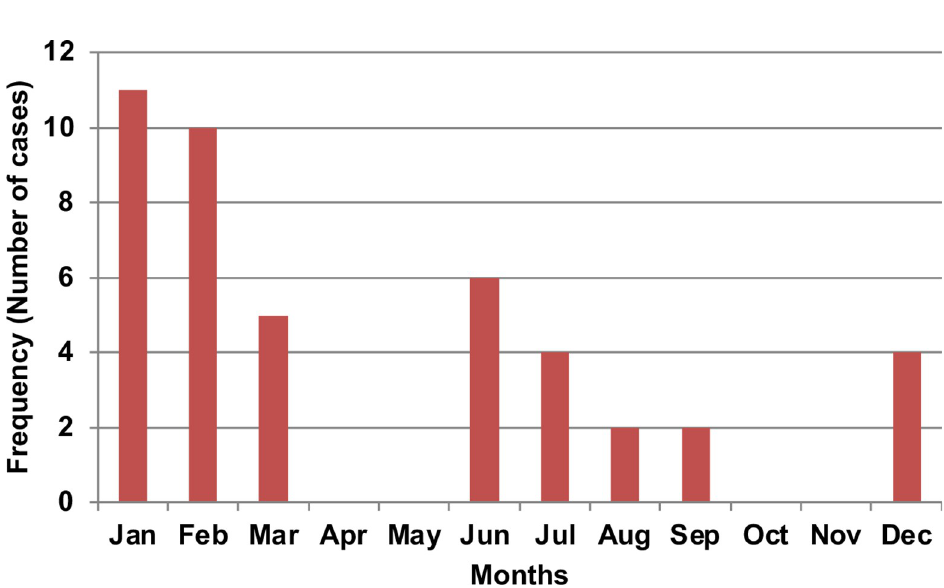
Fig 3. Distribution of confirmed Lassa fever cases in Plateau State according to month of presentation 2016–2018.